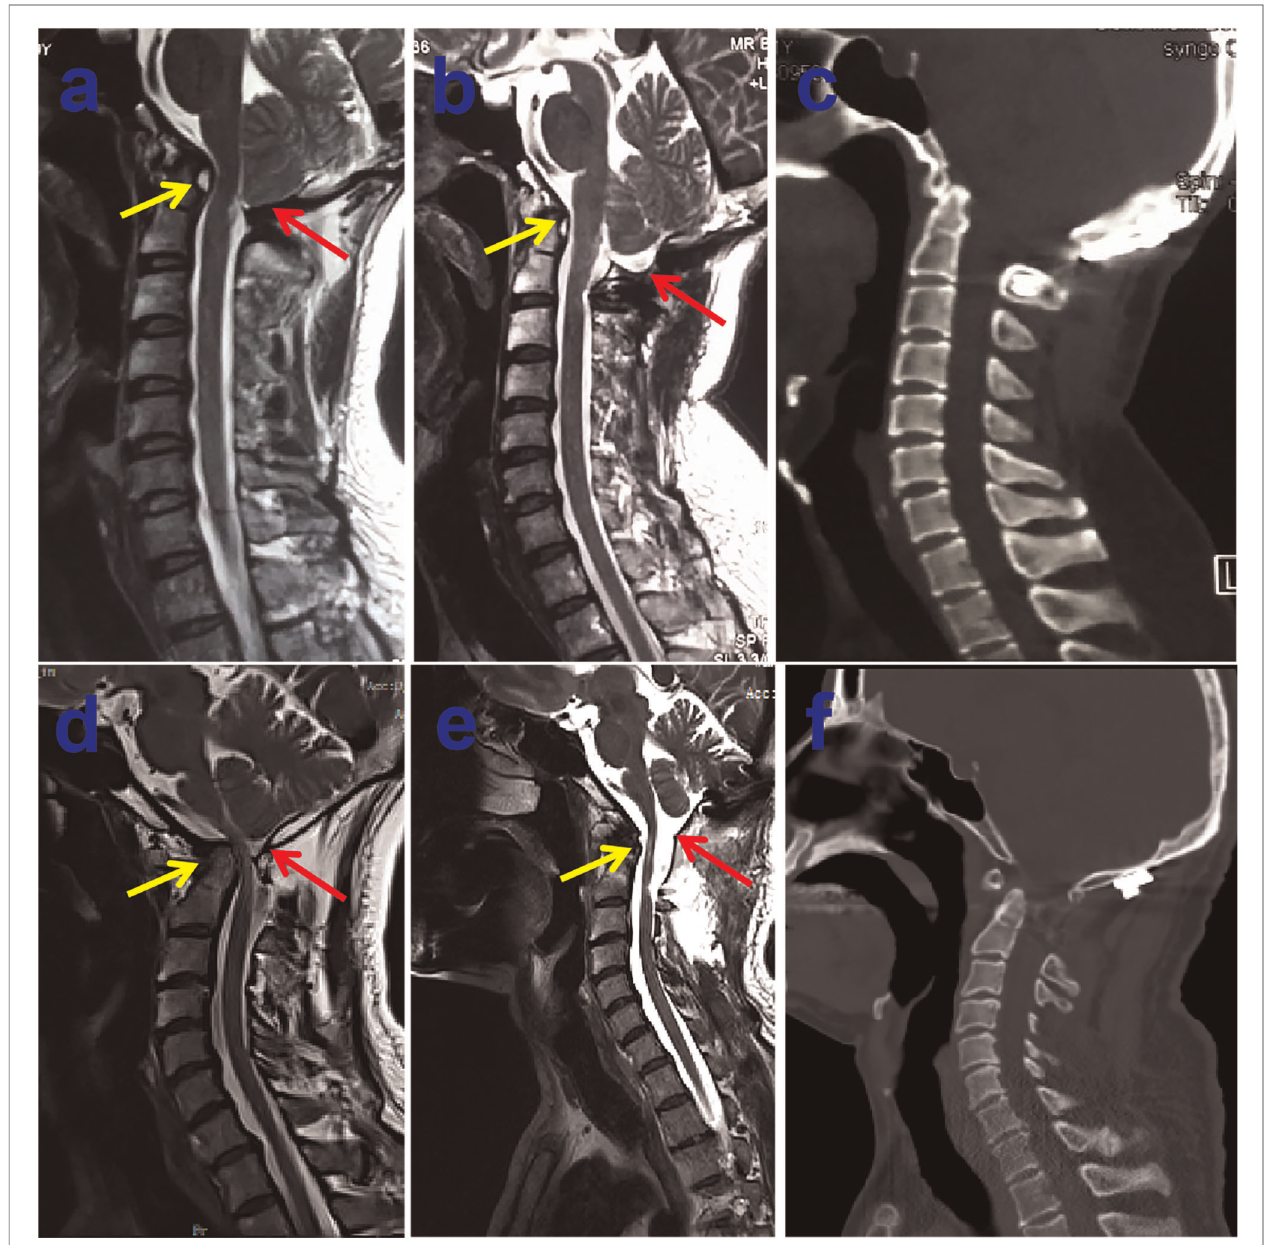
FIGURE 3 | Preoperative midsagittal T2-weighted MRI scan showing slightly ventral compression but no syringomyelia in 40-year-old male patient ( A ), who underwent bony decompression and posterior stabilization of craniocervical junction for numb in both arms and stiff in neck, postoperative midsagittal T2-weighted MRI scan displaying the marked improvement CSF fl ow anteriorly and posteriorly at the foramen magnum ( B ), the postoperative sagittal CT images showing the posterior reduction and stabilization ( C ). Preoperative midsagittal T2-weighted MRI scan showing seriously ventral compression but no syringomyelia in another 51-year-old male patient, who experienced bony decompression and titanium cage implanting as well as posterior stabilization of craniocervical junction for ataxia and weakness in all limbs ( D ), postoperative midsagittal T2-weighted MRI scan illustrating that the compression of brain stem dissolved excellently ( E ), the postoperative sagittal CT images showing the satisfactory distraction after posterior reduction and stabilization ( F